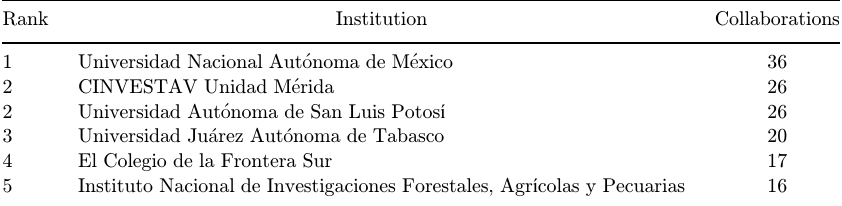
Table 7. Top ranked Mexican institutions that collaborate with academic bodies in UADY. Rank